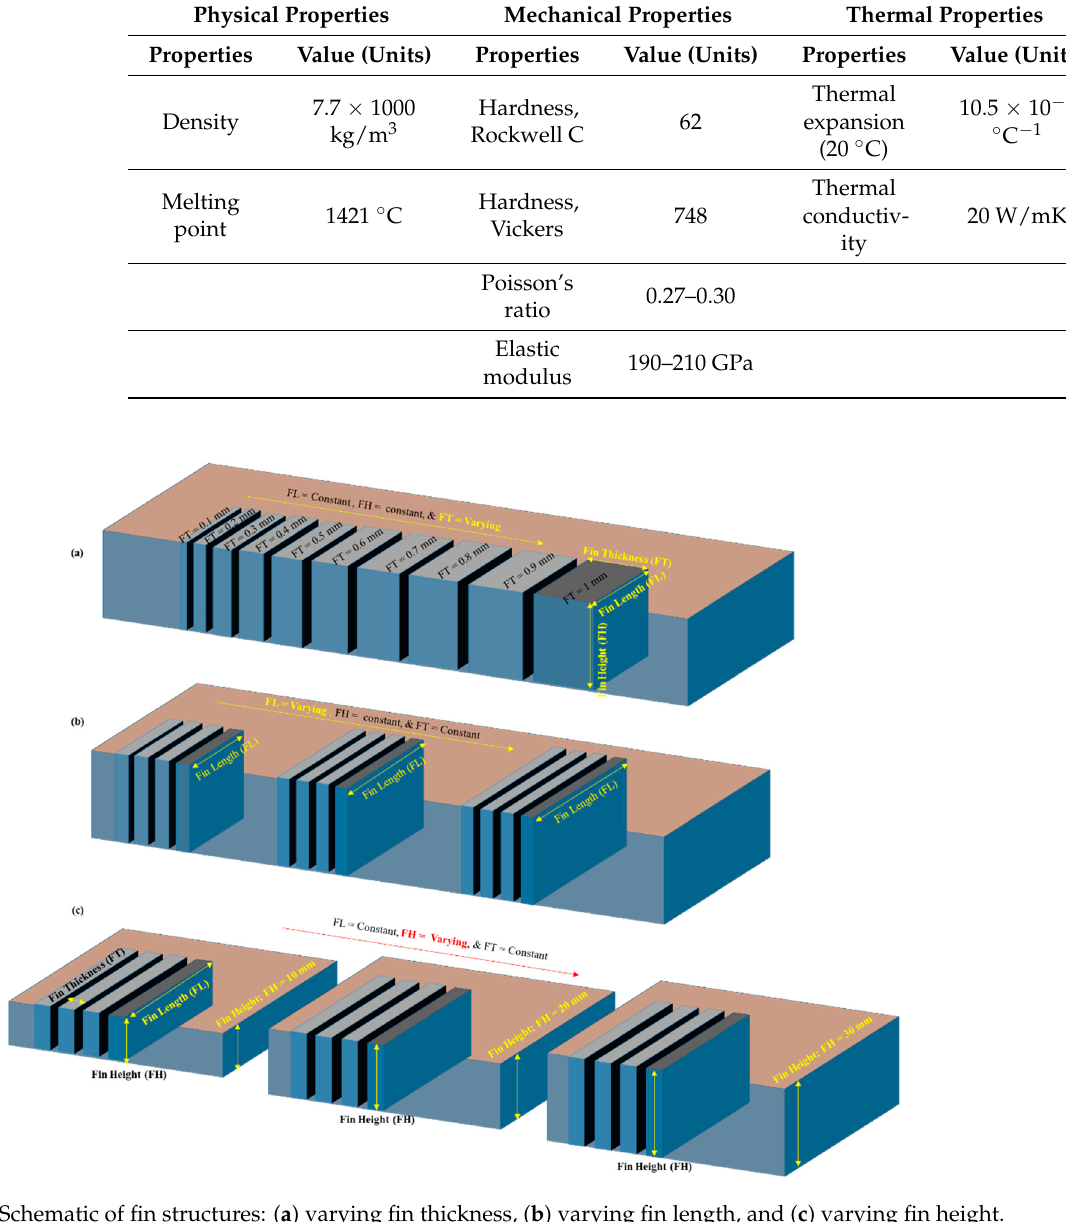
Figure 1. Schematic of fin structures: ( a ) varying fin thickness, ( b ) varying fin length, and ( c ) varying fin height.